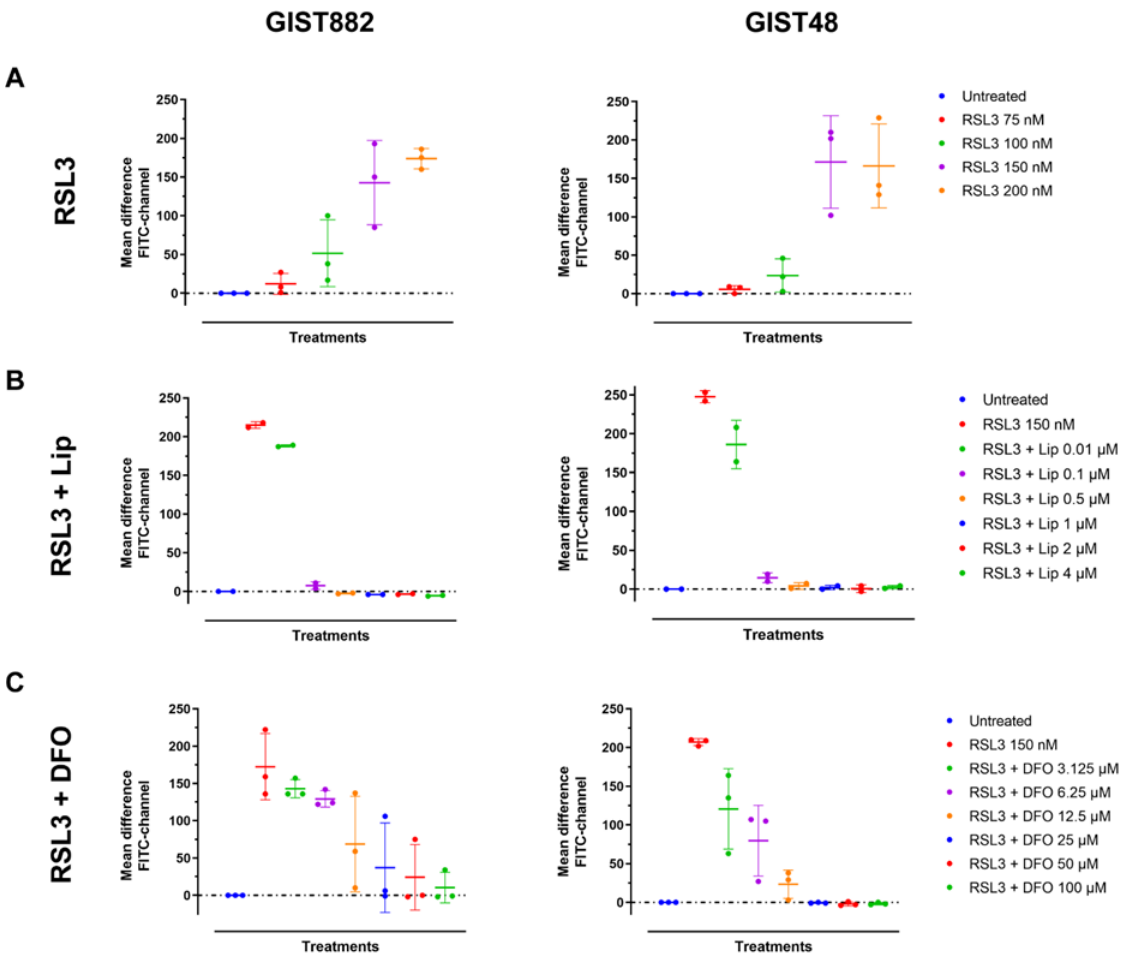
Figure 2. RSL3 treatment in GIST882 and GIST48 cells leads to lipid peroxidation, which is completely inhibited by the antioxidant Lip and by the iron chelator DFO. Lipid peroxidation was assessed by flow cytometry using C11-BODIPY581/591. GIST882 and GIST48 cells are shown in the left and right panels, respectively. ( A ) Cells were treated with indicated concentrations of RSL3 for 3 h and ( B ) with combinations of RSL3 150 nM and different concentrations of Lip or ( C ) different concentrations of DFO. Data were analyzed with DABEST software and scatter plots were generated using Prism 9 software. Data are presented as mean values ±SD. Mean values from two or three independent experiments.